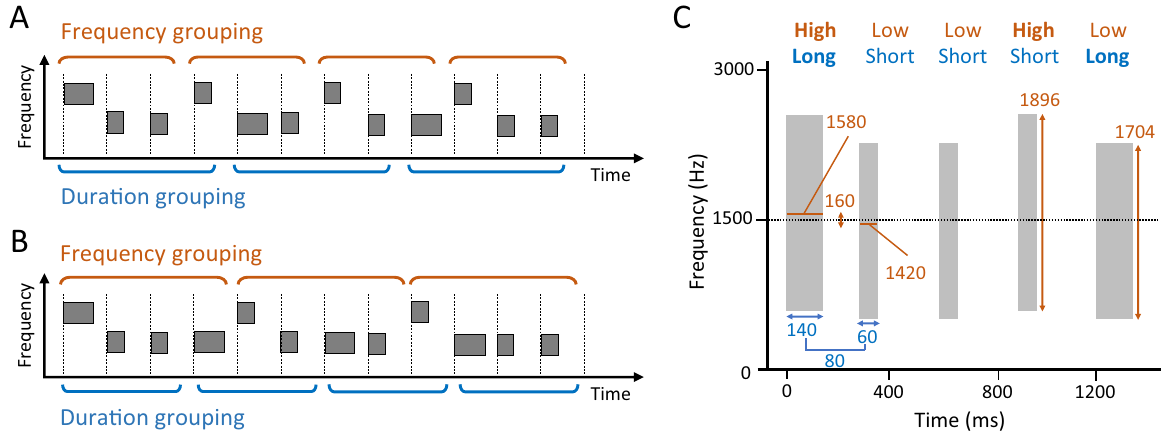
Fig 1. Schematic drawings of the biphasic meter stimuli. The stimuli consisted of various types of band-limited noise bursts. Inter-onset intervals were fixed at 300 ms. A. One type of stimulus had triple-meter regularity in the center frequencies of the noise bursts (high-low-low) and a quadruple cycle in their temporal durations (long-short-short-short). B. Another type of stimulus had the opposite property; triple and quadruple meters were assigned to durations (long-short-short) and frequencies (high-low-low-low), respectively. C. Schematic spectrogram of the former type of stimulus (shown in panel A) when the frequency difference is 160 Hz and the duration difference is 80 ms (F160-D80 condition). The bandwidth was 120% of the center